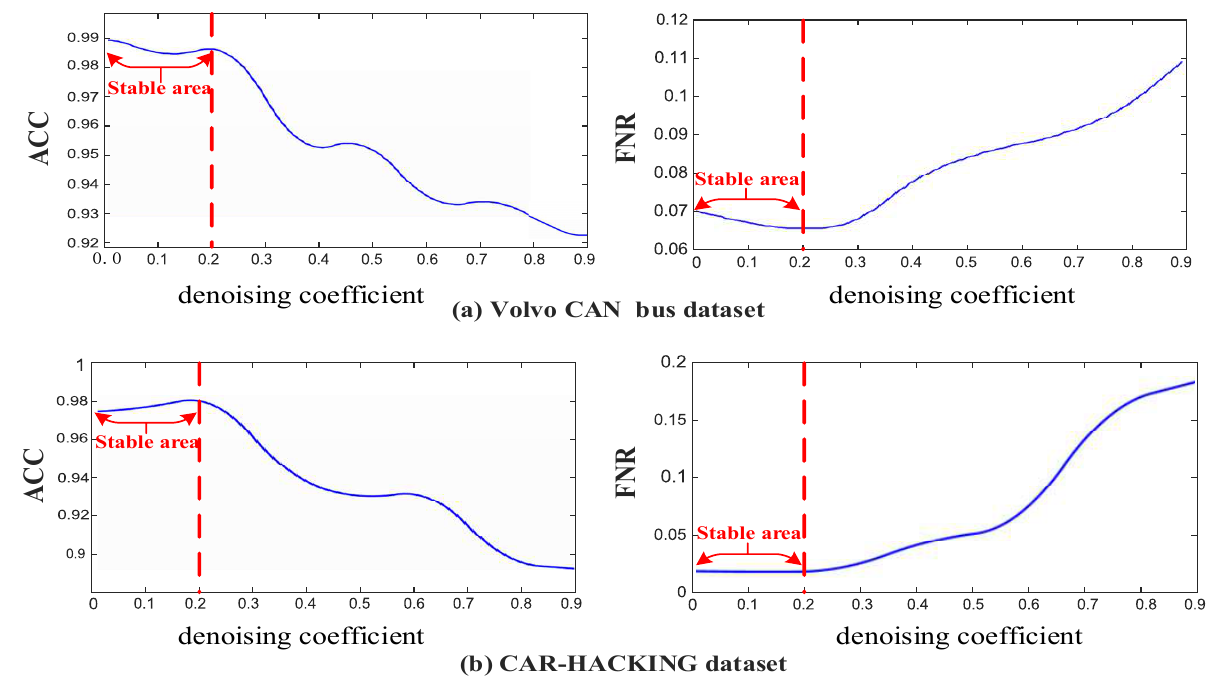
Figure 6. Sensitivity analysis of denoising coefficient σ on two datasets. ( a ) the trend of the SDBL algorithm affected by σ on Volvo CAN bus dataset; ( b ) the trend of the SDBL algorithm affected by σ on CAR--HACKING dataset.